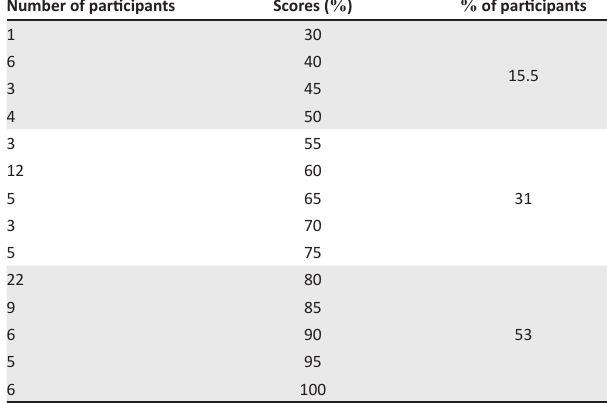
TABLE 2: Participants’ knowledge of ototoxic medicines and their side effects.